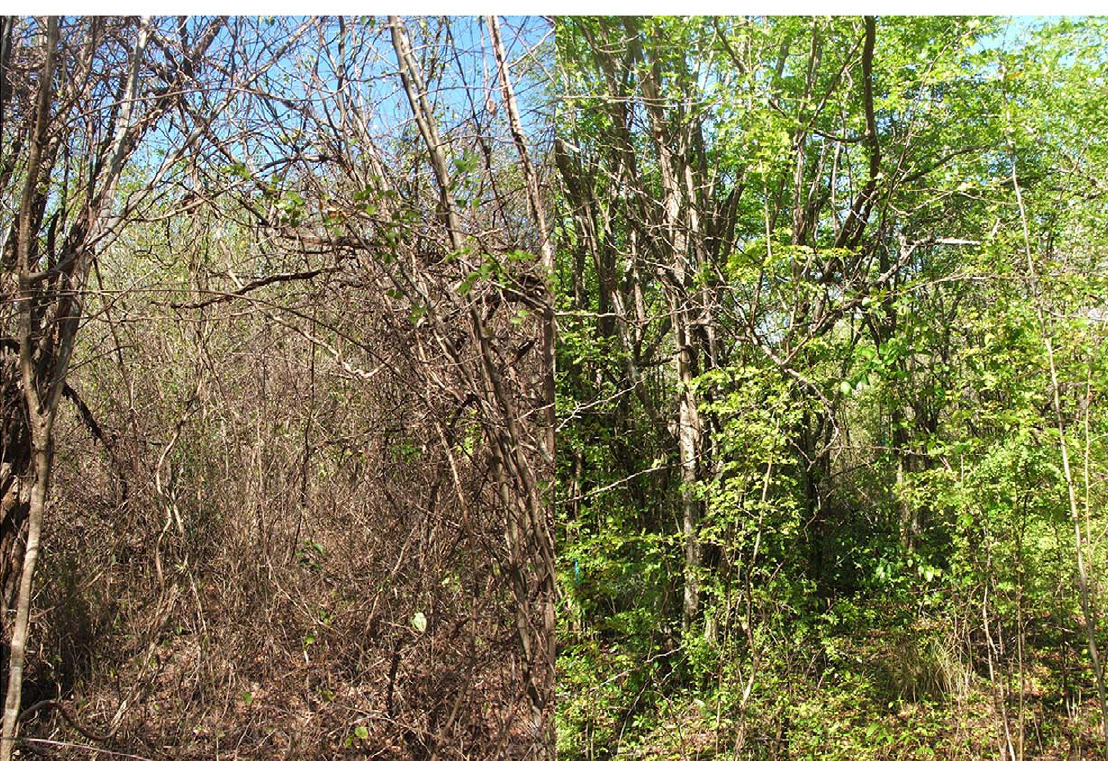
Figure 2. Effects of experimental irrigation on dry season scrub habitat at the Font Hill Nature Preserve, Jamaica. A control plot is shown on the left and an irrigated plot on the right. Photos were taken in late March after the second round of irrigation.